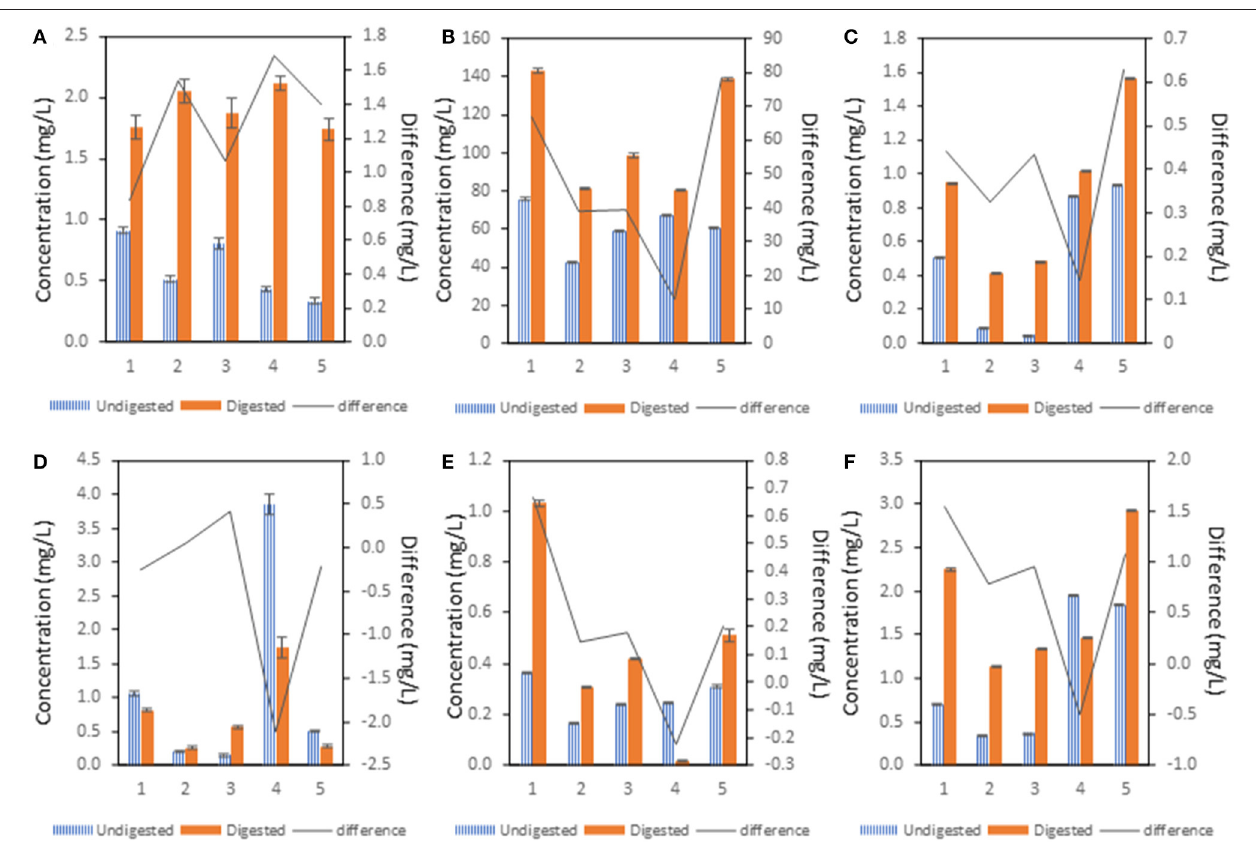
FIGURE 4 | The influence of treatment of pea flour [(1): untreated flour, (2): cooked at 100 ◦ C for 10min, (3): cooked at 100 ◦ C for 120min, (4): fermented flour without cooking, (5): fermented flour cooked at 100 ◦ C for 120min.] on mineral concentration. The difference was calculated after subtraction of the concentration of the undigested sample from the digested sample. (A) P, (B) Mg, (C) Mn, (D) Fe, (E) Cu, (F)